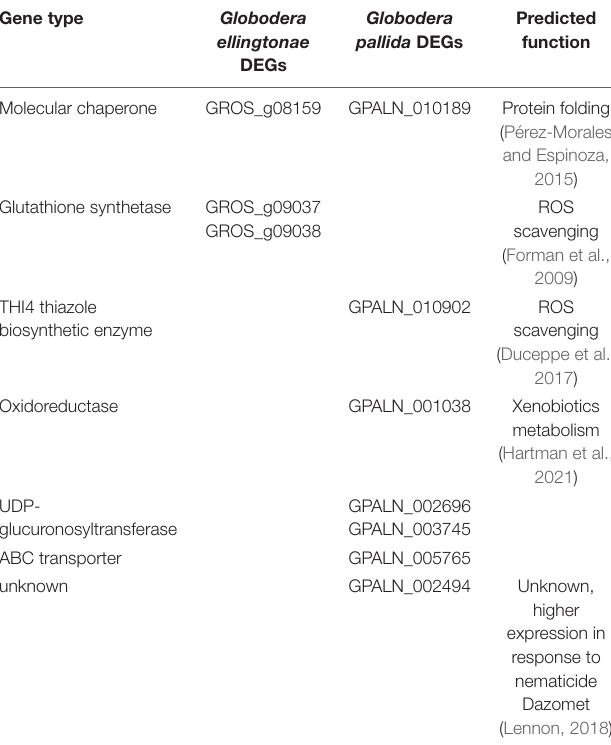
TABLE 2 | Predicted parasitism genes differentially regulated in SSI hatching treatment compared with potato hatching treatments (resistant - INN or susceptible - DS).